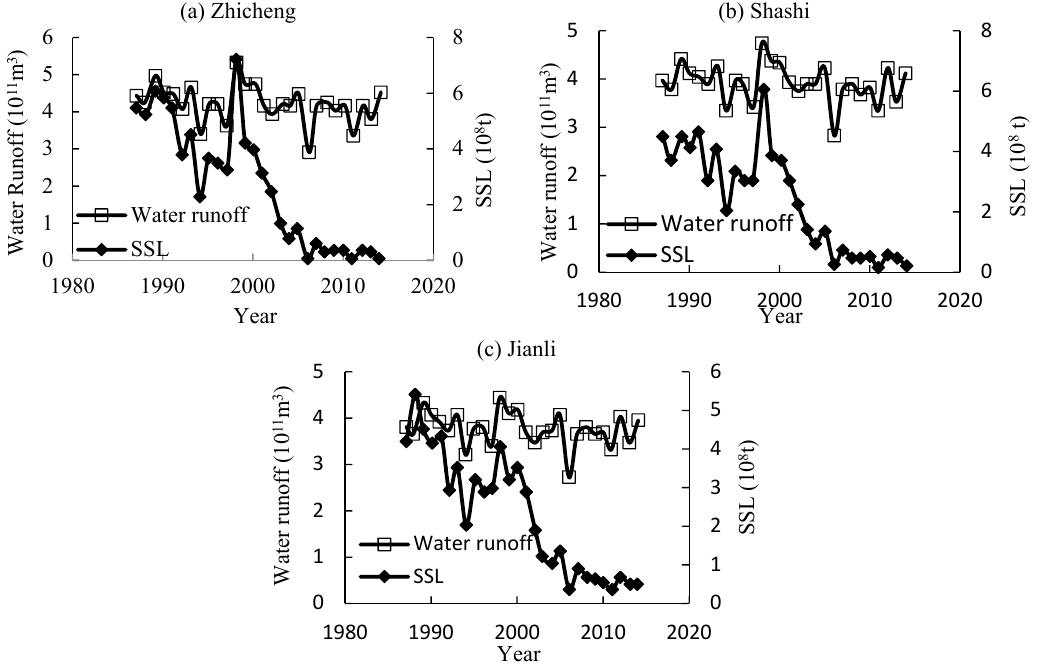
Figure 6. Temporal variation of water runoff and SSL in the JJRR.